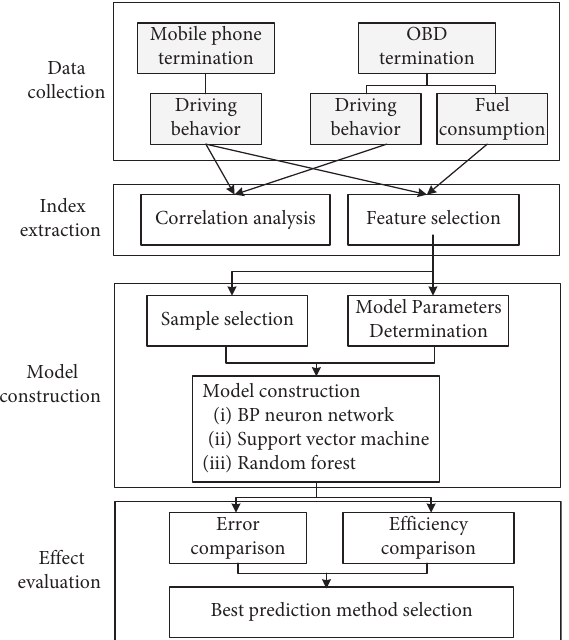
Figure 1: The framework of model construction. OBD means on- board diagnostic system and BP represents back